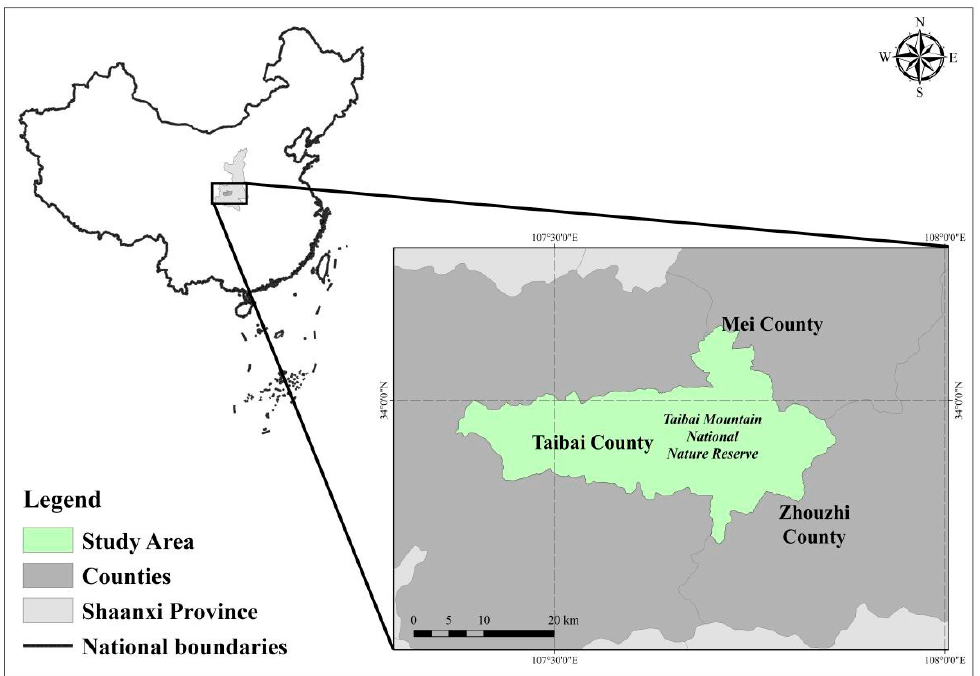
Figure 2. Map of study area.